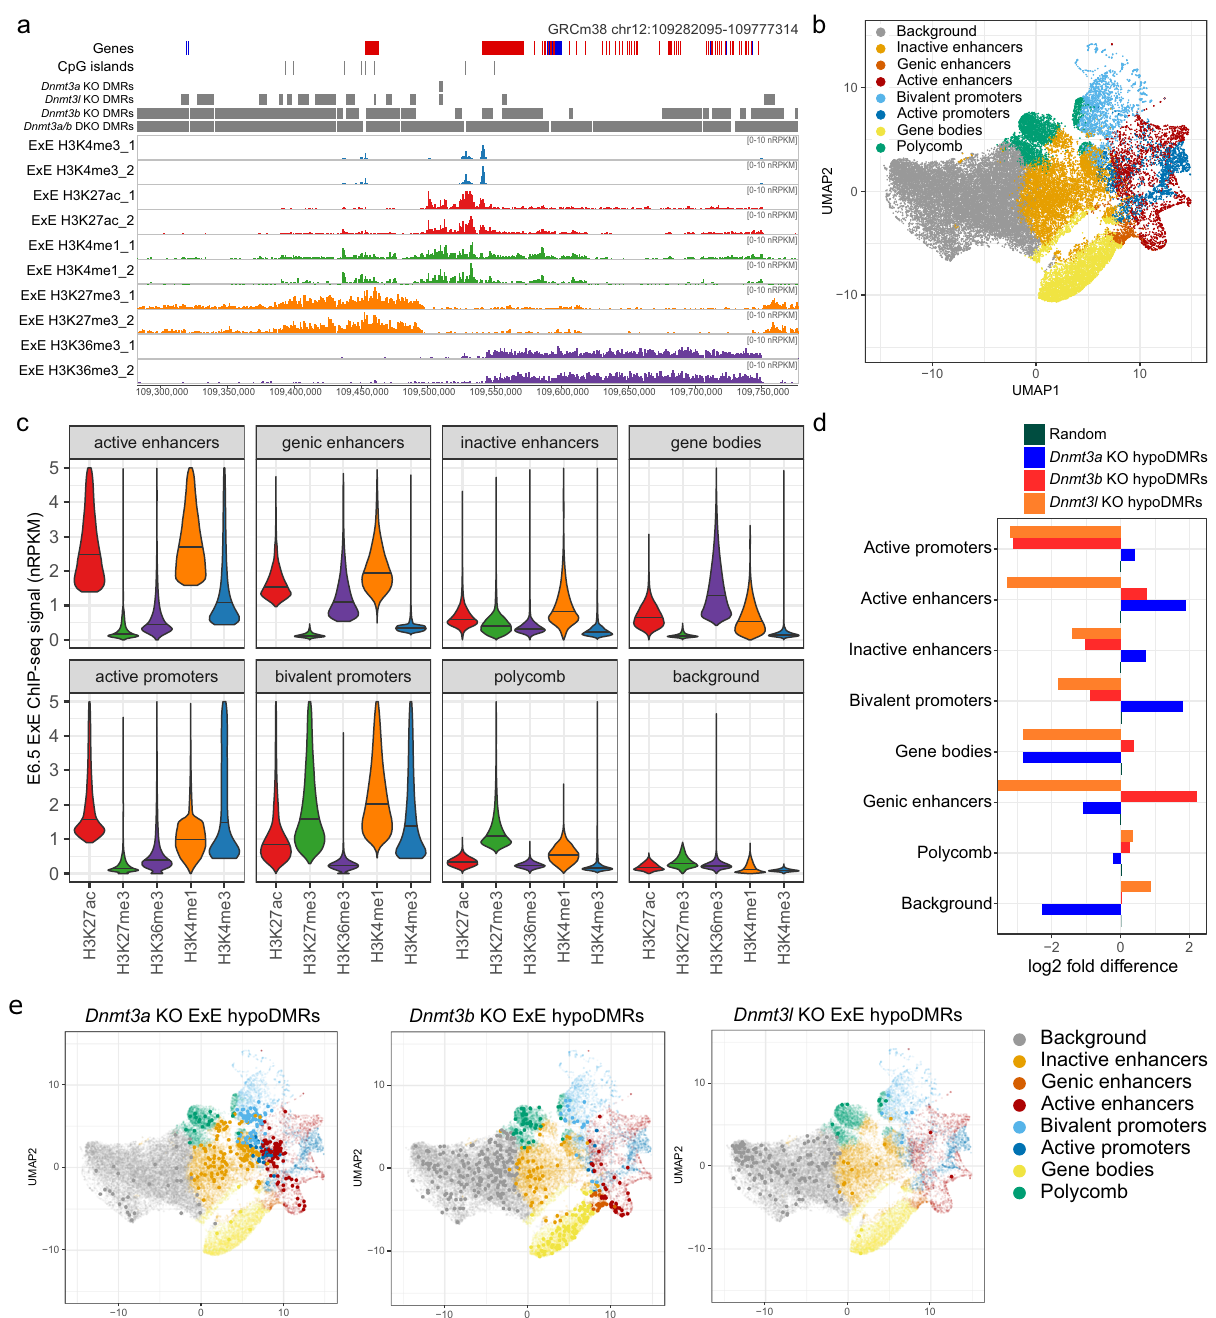
Fig. 2 | Targeting of de novo DNMTs in ExE depends on underlying chromatin landscape. a The genome browser shot shows ChIP-seq replicates for H3K4me3, H3K27ac, H3K4me1, H3K27me3 and H3K36me3 in E6.5 extra-embryonic ectoderm (ExE), using 1kb running windows and enrichment normalised RPKM. Hypo- methylated differentially methylated regions (DMRs) identi fi ed in the Dnmt3a , Dnmt3l , Dnmt3b and Dnmt3a/b KOs using logistic regression and >20% difference are shown asannotation tracks. b Eight distinctchromatin features wereidenti fi ed using UMAP dimensionality reduction and clustering of 100-CpG windows using